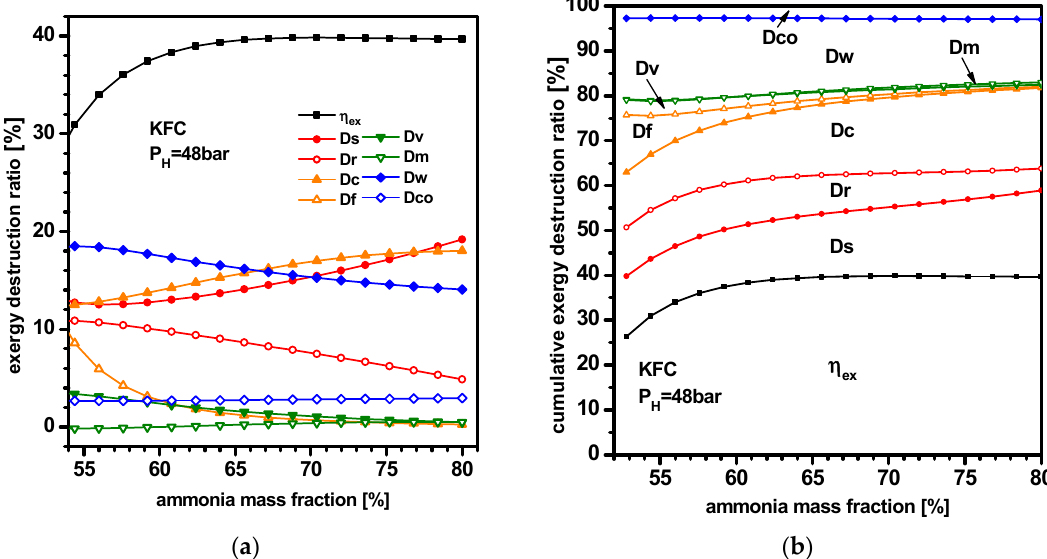
Figure 13. Dependence of ( a ) separate and ( b ) cumulative ratios of exergy consumption on the ammonia mass fraction for P H = 48 bar in the KFC.